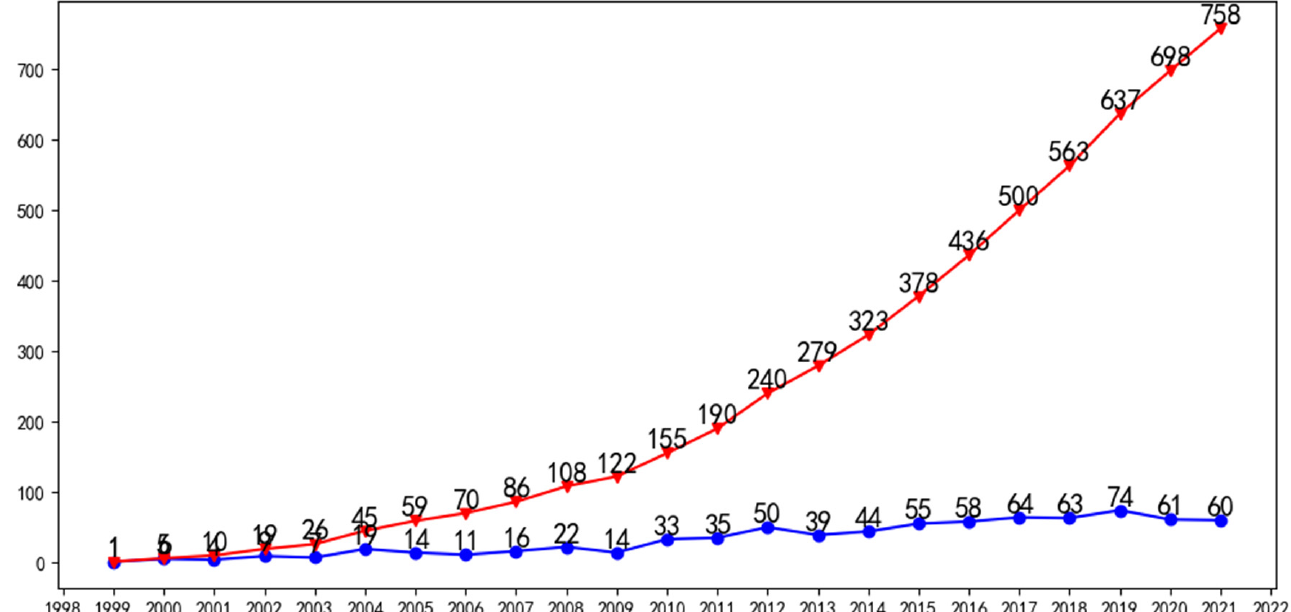
Figure 1. Annual and accumulated publications from 1999 to 2021 about evaluation of antioxidants using electrochemical sensors.